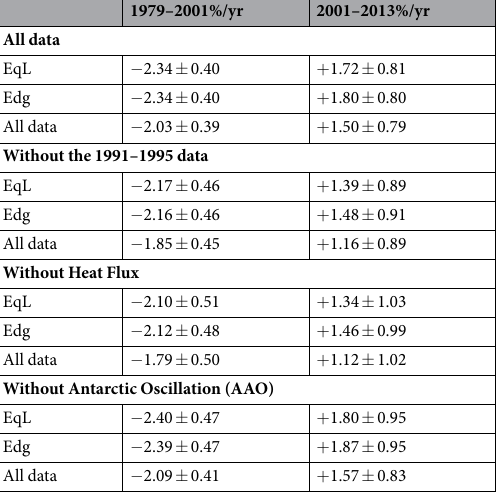
Table 1. Total Column Ozone trends in Antarctic Spring: The piece-wise linear trends (PWLT) estimated from satellite total column ozone (TCO) measurements averaged over September, October and November (SON, spring) from selected Antarctic stations. The error bars represent the 95% confidence interval. The measurements averaged over the vortex criteria ≥ 65° S EqL are represented by EqL , the measurements averaged over the Nash et al . 20 vortex criteria are represented by Edg , and the averages of data poleward of 65° S without considering vortex definitions are represented by All data